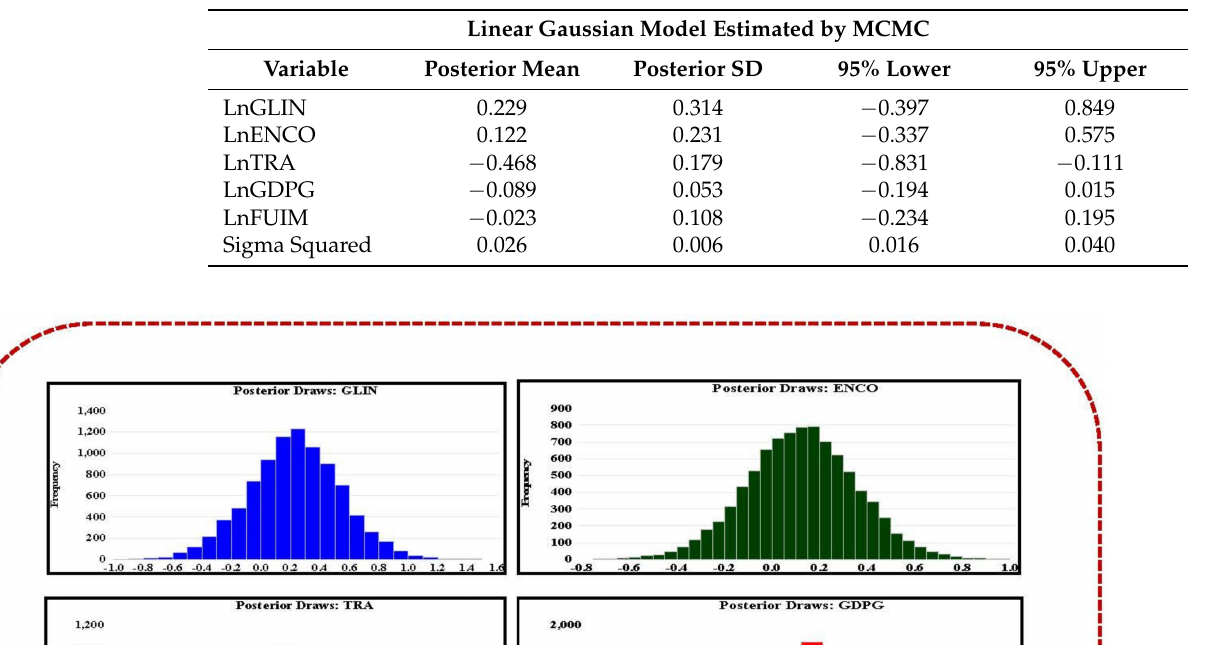
Table 7. Outcomes of linear Gaussian model estimation.